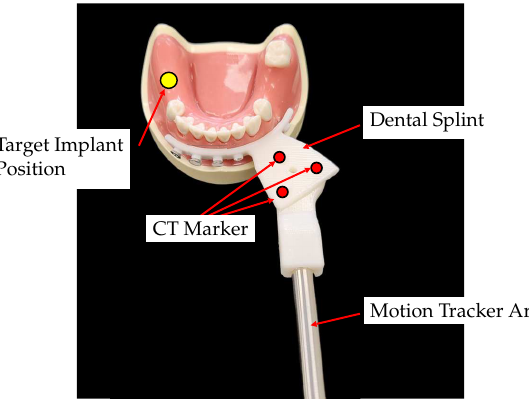
Figure 2. The dental splint to connect the motion tracker and the patient.